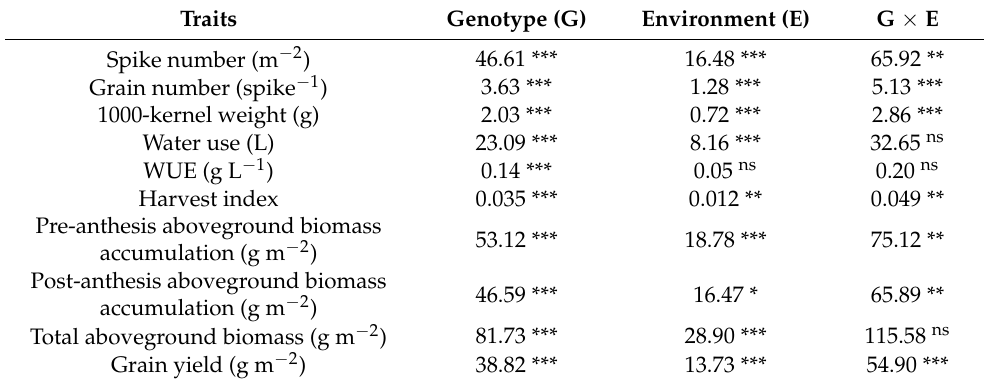
Table 1. The effect of genotype (G) and environment (E) and their interaction (G X E) on grain yield and yield-related traits of spike number, grain number per spike, 1000-kernel weight, water use from sowing to maturity, water use efficiency (WUE), harvest index, pre-anthesis aboveground biomass accumulation, post-anthesis aboveground biomass accumulation, total aboveground biomass, and grain yield. * p < 0.05; ** p < 0.01; *** p < 0.001; ns not significant. The values before the asterisks are the least significance differences at p =